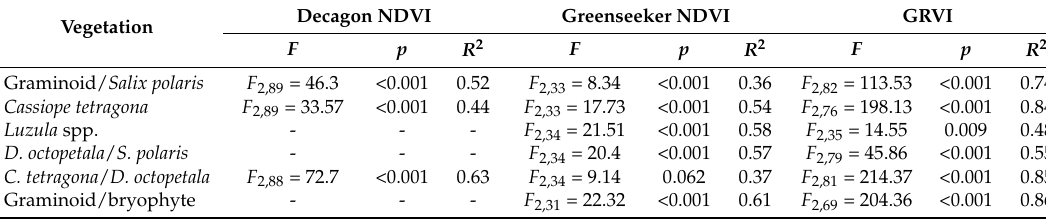
Table 2. Relationships between day of year and values of different vegetation indices in six different High Arctic vegetation types. GRVI values outside the 95% confidence interval of the linear model have been omitted from the analyses to exclude obviously erroneous data. Decagon NDVI Greenseeker NDVI Vegetation